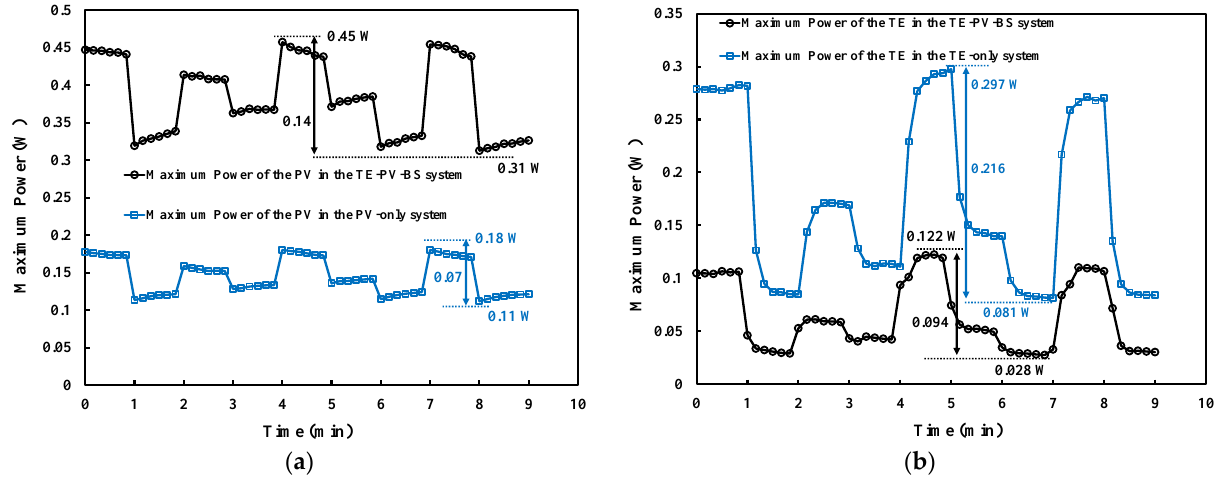
Figure 6. Maximum power comparison between ( a ) PV cell in the PV-only and TE-PV-BS systems, and ( b ) TE module in the TE-only and TE-PV-BS systems.